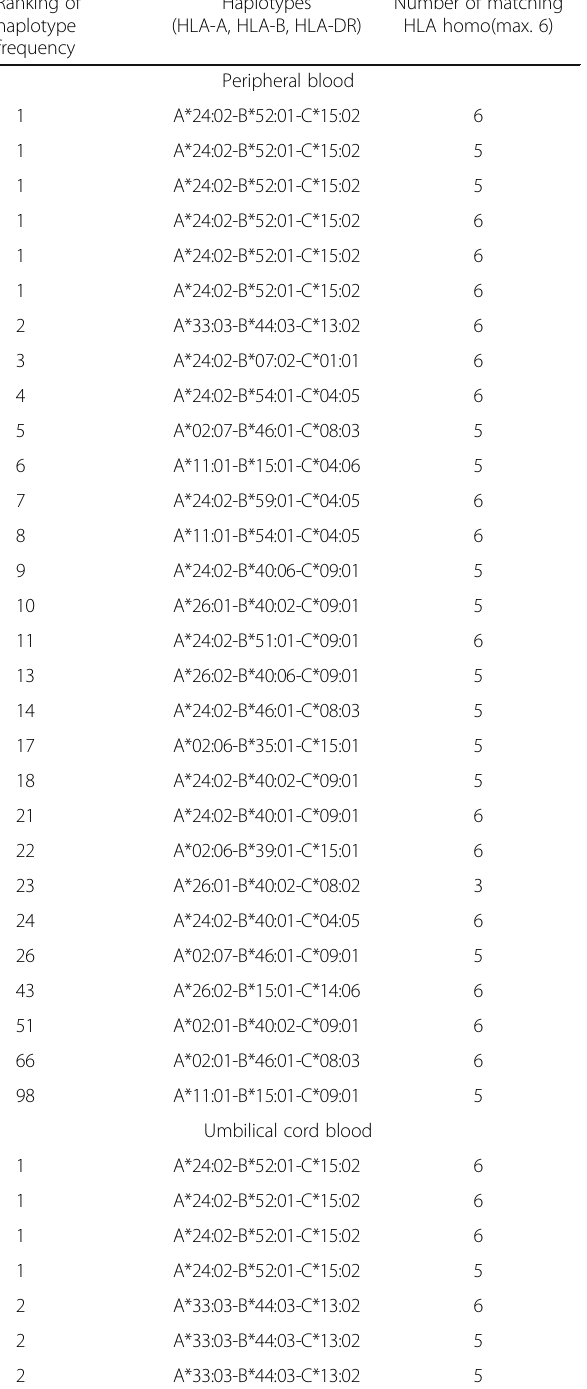
Haplotypes (HLA-A, HLA-B, HLA-DR)